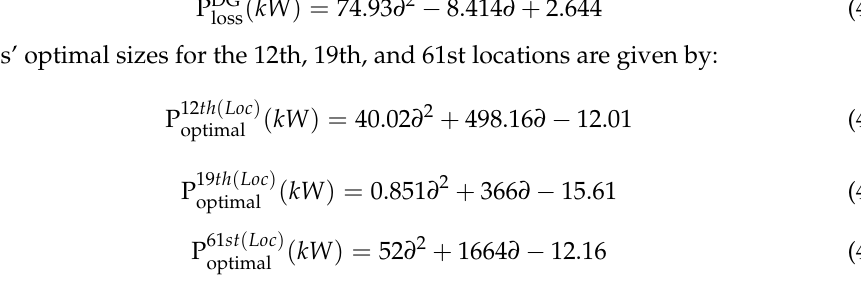
( d ) Figure 12. ( a ) IEEE 69-test system voltage profile (Scenario I). ( b ) IEEE 69-test system voltage profile (Scenario II). ( c ) IEEE 69-test system voltage profile (Scenario III). ( d ) IEEE 69-test system voltage profile (Scenario IV).